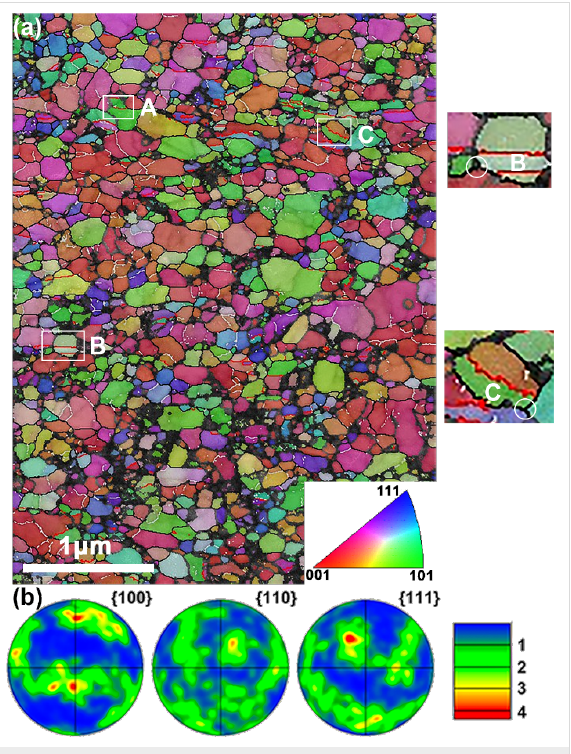
Figure 1: A typical bright-field TEM image of the HPT Cu–Zn alloy showing severe deformation and grain refinement. Inset is a corre- sponding selected area diffraction pattern.